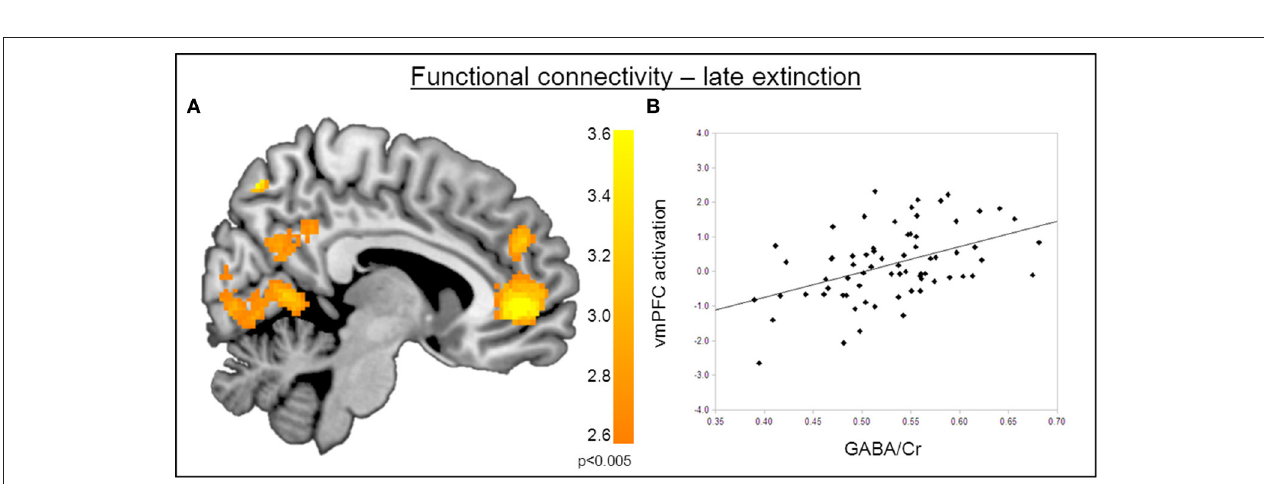
FIGURE 6 | Functional connectivity during late extinction. (A) A psychophysiological interaction analysis revealed that high levels of GABA mediate an increase in connectivity between the amygdala seed region and the vmPFC (MNI x,y,z = − 4, − 40, − 10) during extinction (P FWE < 0.05). (B) Correlation plot illustrating a positive relation between dACC GABA levels and amygdala-vmPFC